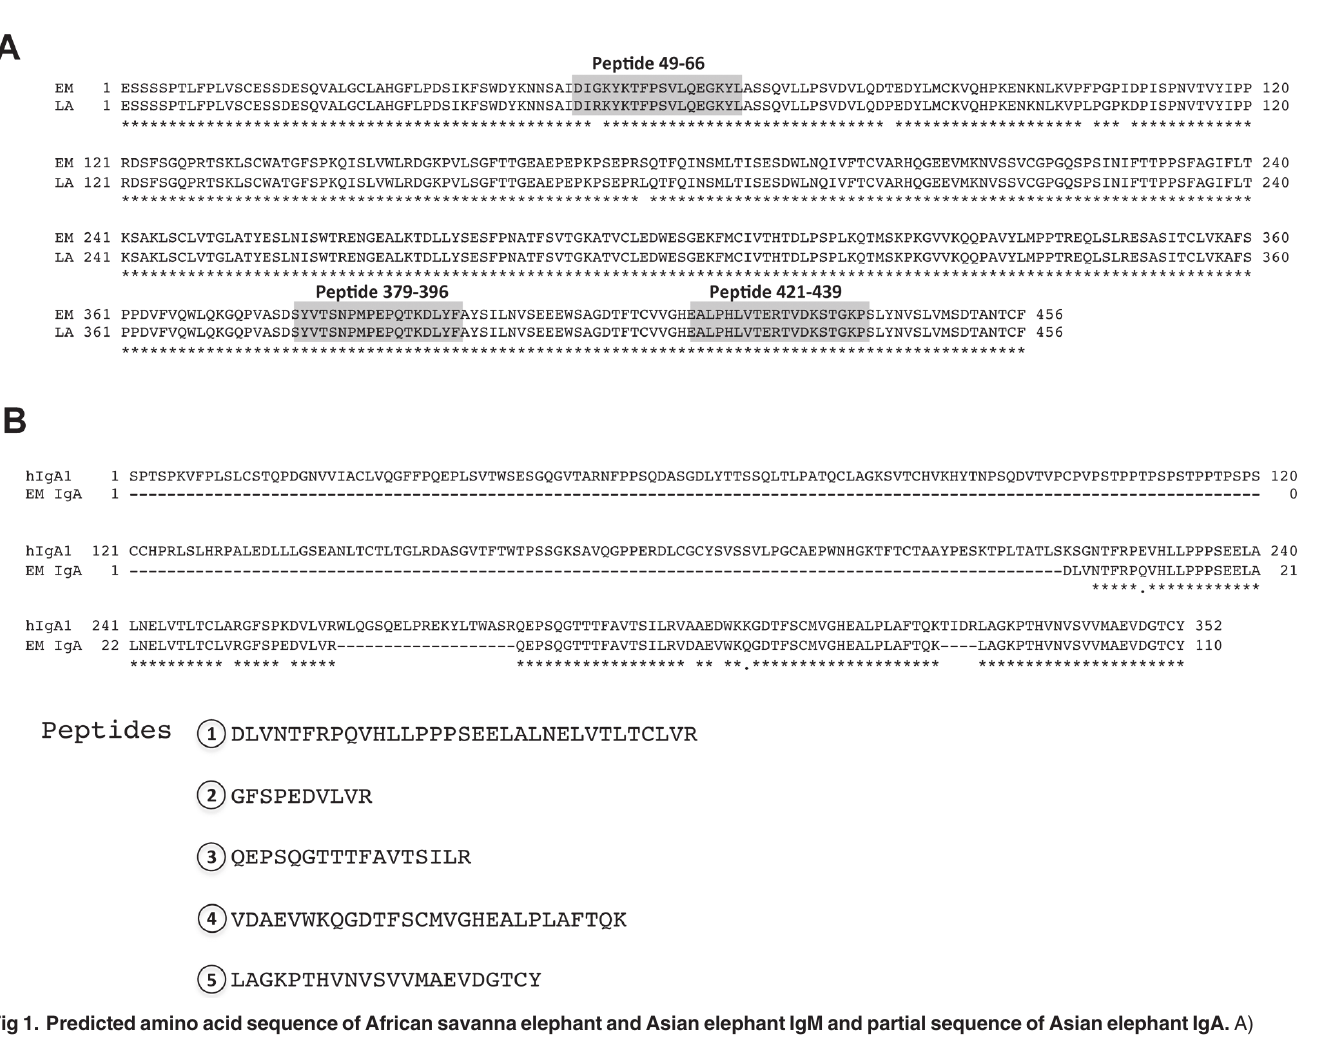
PLOS ONE | DOI:10.1371/journal.pone.0116318 February 6,